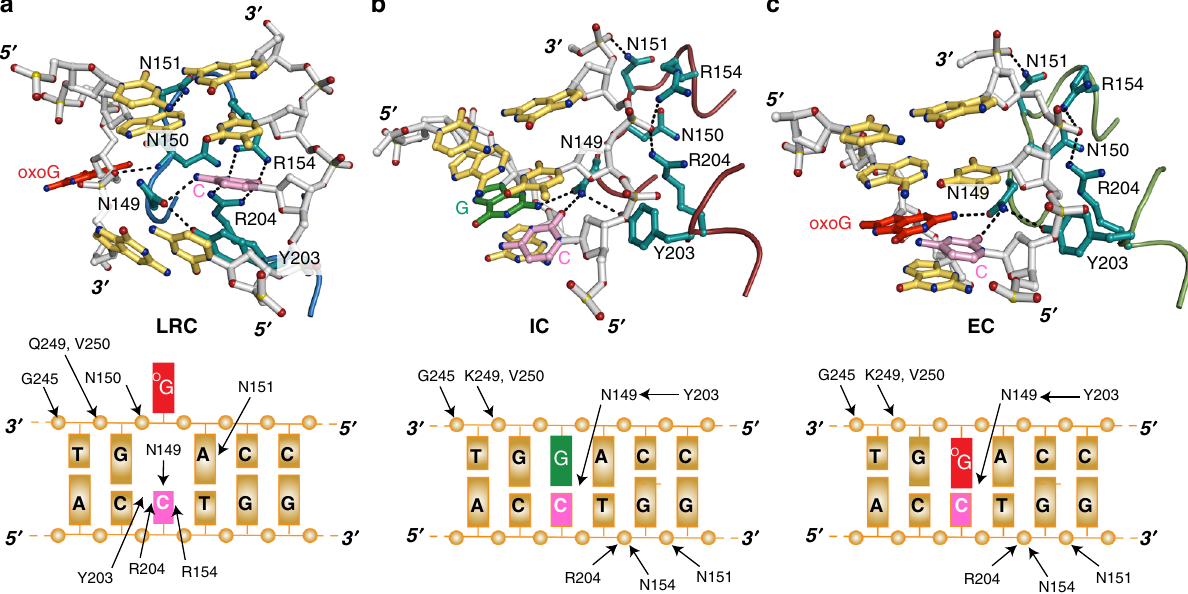
Fig. 4 Close-up views of key interactions of hOGG1 with DNA. a Crosslinked LRC; b IC; and c EC. Dashed lines indicate hydrogen bonding interactions among DNA bases, backbone and residues in hOGG1. Color-coding is as in Fig. 2, except for the sidechains of key residues (N149, N150, N151, R154, Y203, and R204), which are shown in cyan. In each fi gure, the lower panel is a schematic DNA sequence diagram illustrating the residues that interact with DNA shown in the upper panel. The interactions are indicated with arrows.